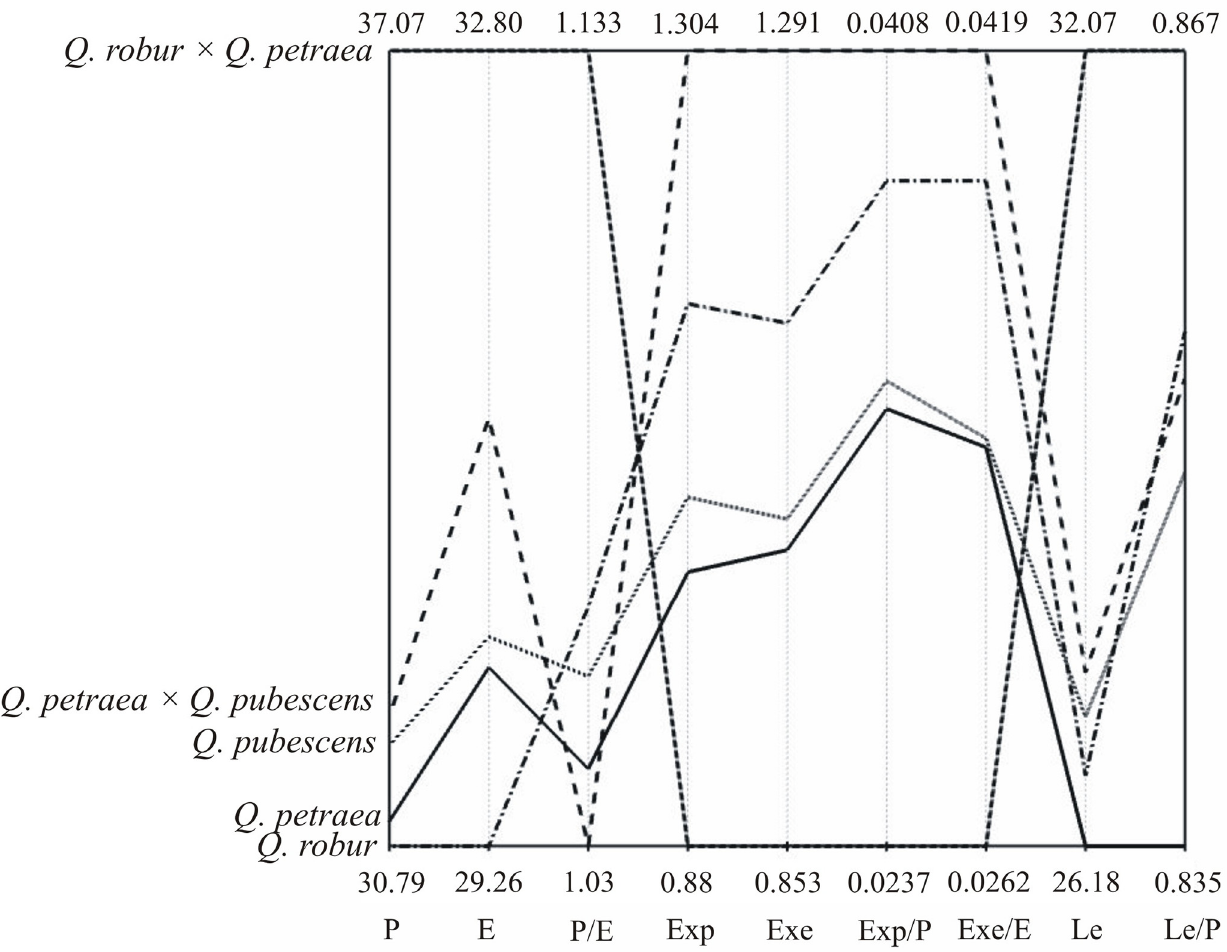
Fig 4. Parallel coordinate plots (PCPs) for five studied taxa and nine traits (P, E, P/E, Exp, Exp/P, Le, Le/P).